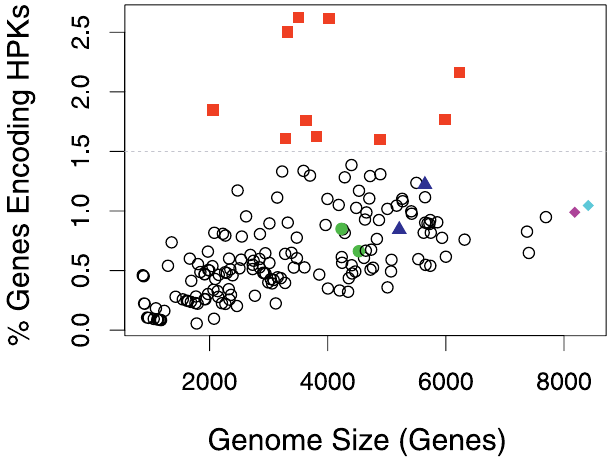
Figure 2. HPK Content versus Genome Size The percent of each genome is plotted as a function of genome size. As reported in previous studies, there is a roughly linear correlation. Highlighted in colored symbols are several groups of genomes described in the text: genomes coding a high ( (cid:2) 1.5%) fraction of HPKs—red squares; the model organisms, E. coli and B. subtilis— green circles; genomes with a high number of HGT events — blue triangles; Bradyrhi- zobium japonicum (high number of both HGT and LSE genes) — pink diamond; and Streptomyces coelicolor (high percentage of LSE genes) — turquoise diamond.